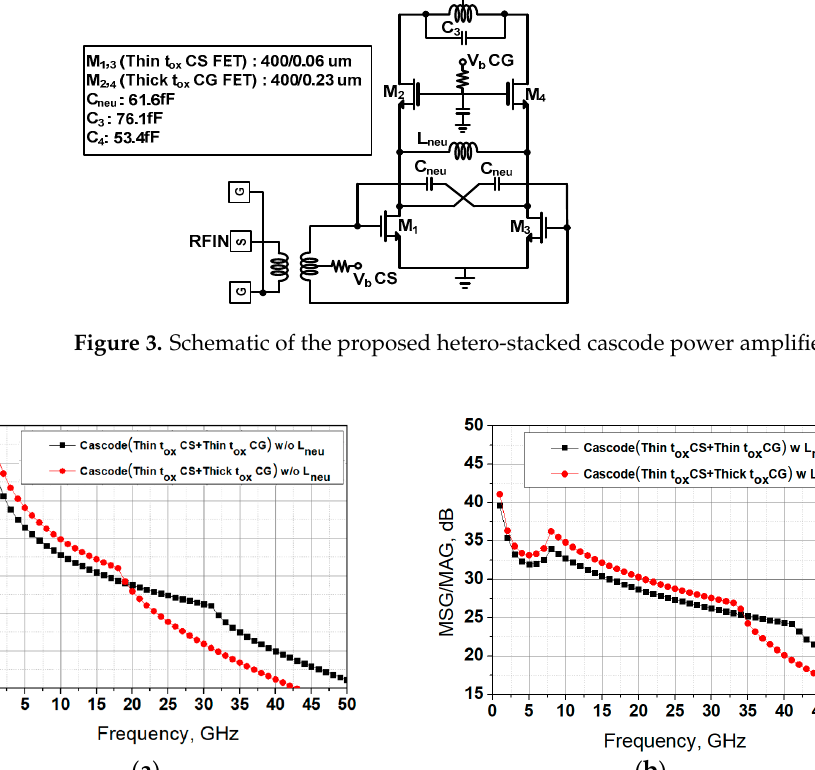
Figure 5. Simulated MAG according to neutralization frequency (thin-oxide FET CS + thin/thick-oxide FET CG). 4. Measurement Results The chip microphotograph is shown in Figure 6. The chip size is 0.7 × 0.63 mm 2 in- cluding all pads. The proposed PA is fabricated using 65-nm low power (LP) CMOS tech-